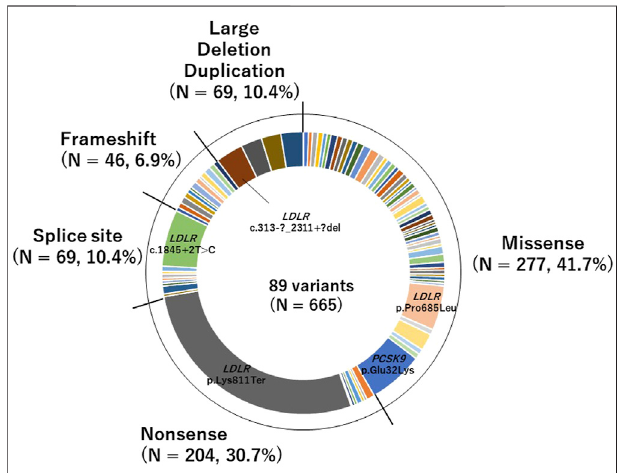
FIGURE 1 | Pie chart ofpathogenic variants identi fi ed in this study of the pathogenic variants, 277 were classi fi ed as missense variants, and 388 were classi fi ed as PTVs (46 were frameshift variants, 69 were large deletion or duplicationvariants,204werenonsensevariants,and69weresplicesite